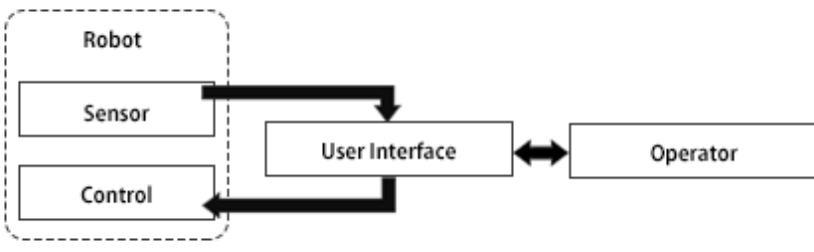
Figure 1. High-level information flow for teleoperation applications.